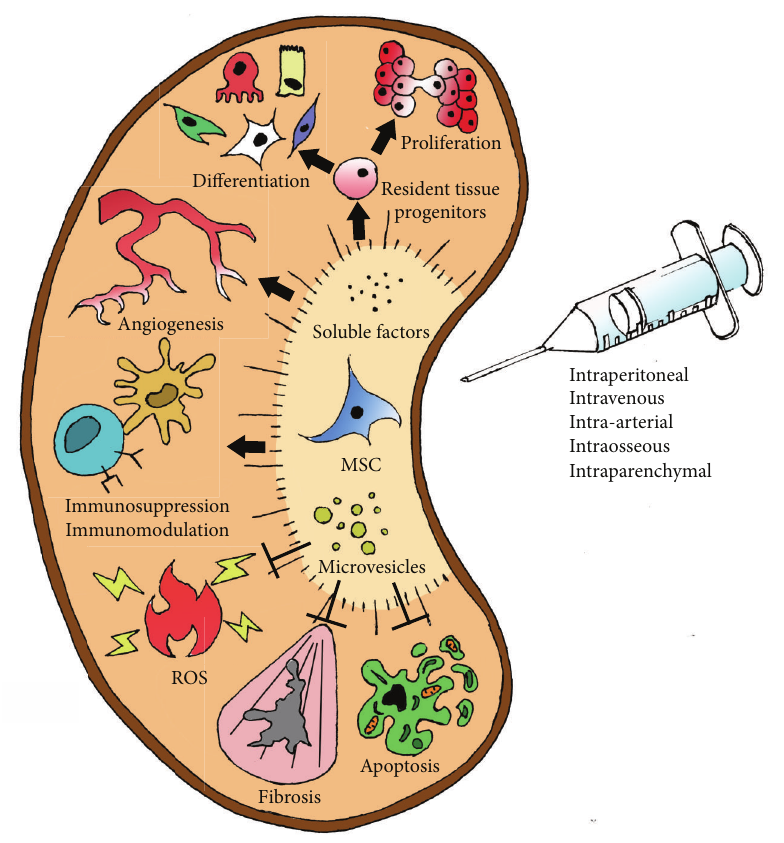
Figure 2: Properties of MSC in kidney diseases. MSC, soluble factors, or microvesicles can be delivered to the kidney via the intraperitoneal, intra-arterial, intravenous, intraparenchymal, or intraosseous route. They exert a series of renoprotective and regenerative actions on the injured tissues through various paracrine mechanisms: antifibrotic and antiapoptotic, proangiogenic, proliferative and differentiative, antioxidative stress, and immunosuppression and immunomodulation of the immune system. ROS: reactive oxygen species. Arrow: enhancement; T-bar: